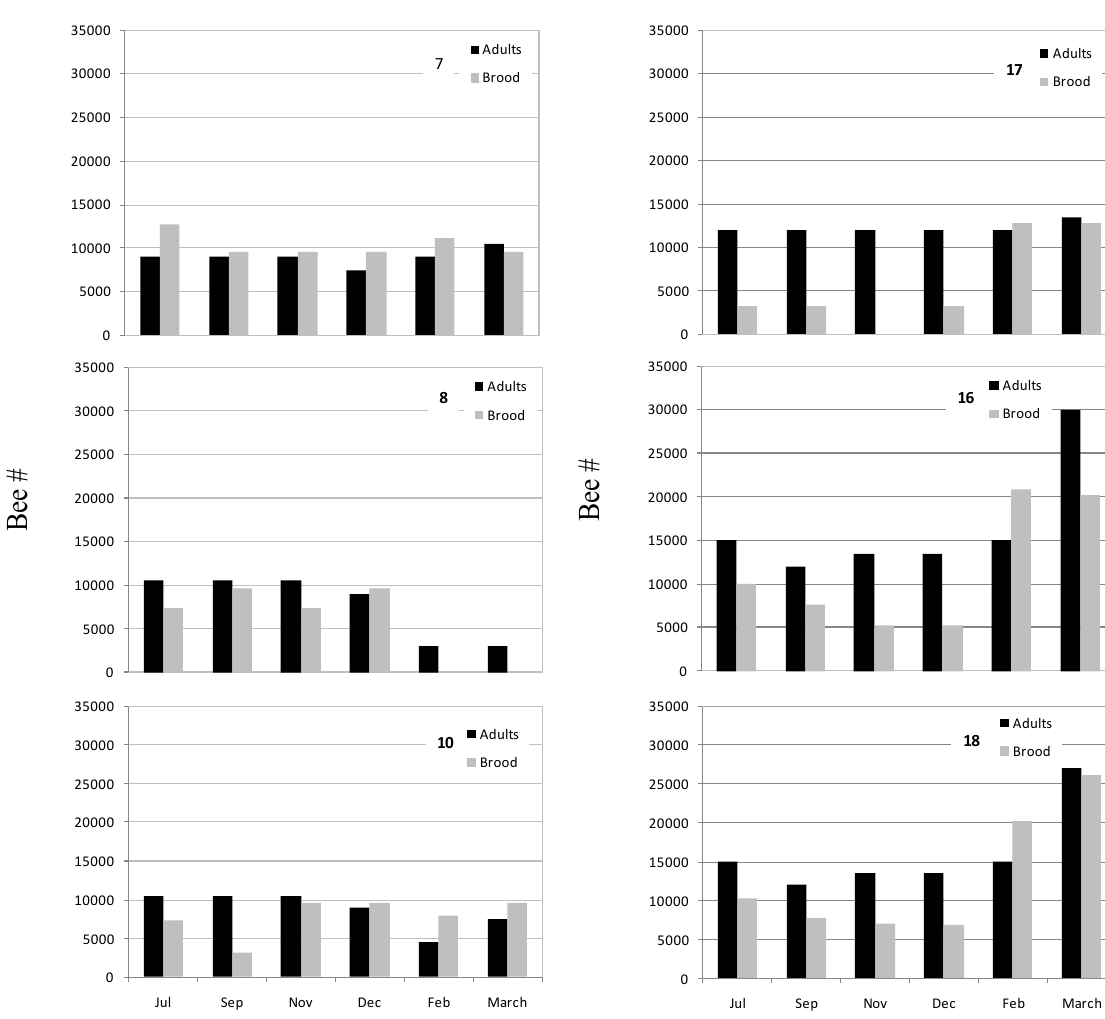
Figure 5. Honey bee population in IAPV-positive, CCD- and healthy control colonies. Adult (black) and brood (gray) . CCD-colonies, 7, 8 and 10. Non-CCD colony, 17. Control colonies, 16 and 18. Colony numbers are indicated in each